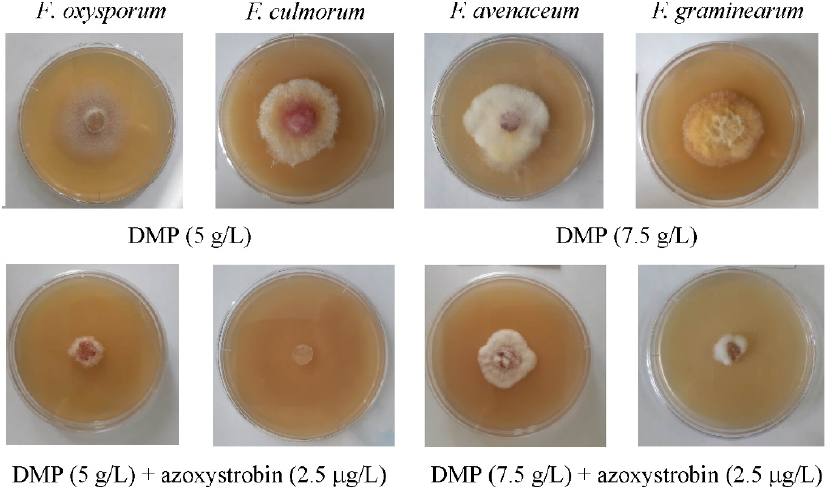
Figure 9. Colony growth of Fusarium oxysporum , F. culmorum , F. graminearum and F. avenaceum on the PDA medium containing DPM ( top line ) or DPM + azoxystrobin combinations ( bottom line ).